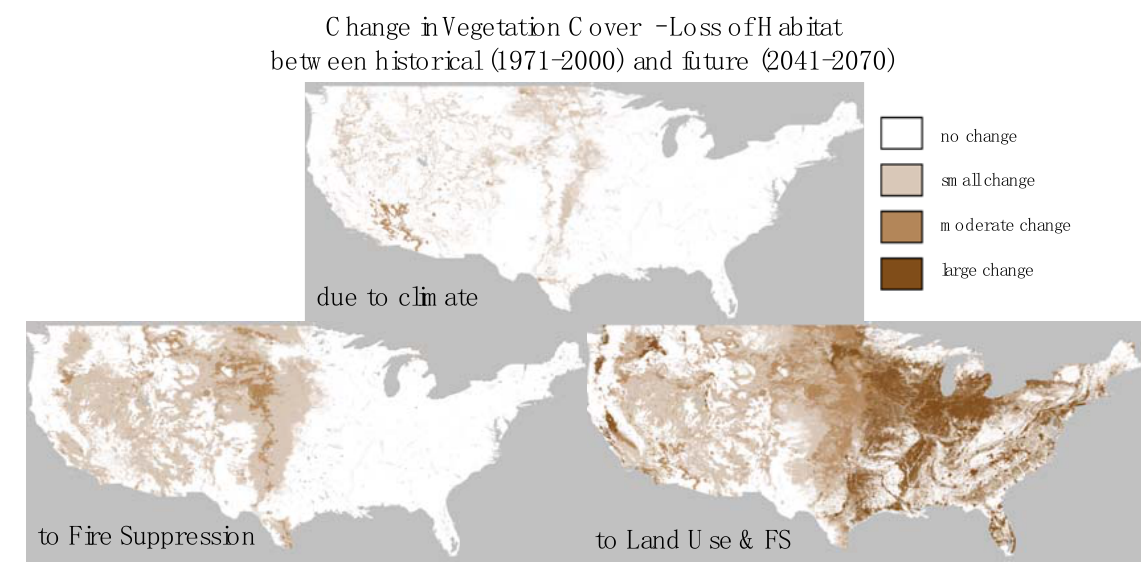
Figure 3. Simulated change in vegetation cover between historical conditions (1971–2000) and future conditions across 3 possible futures (climate projections from CGCM3, MIROC and CSIRO) under the A2 emission scenario (2041–2070). We show simulation results at 30 arcsec spatial resolution without fire suppression (potential vegetation)—changes are due only to climate effects, with only fire suppression—changes are due to both climate and suppression, with fire suppression and land use— changes are due to climate, fire suppression and land conversion.